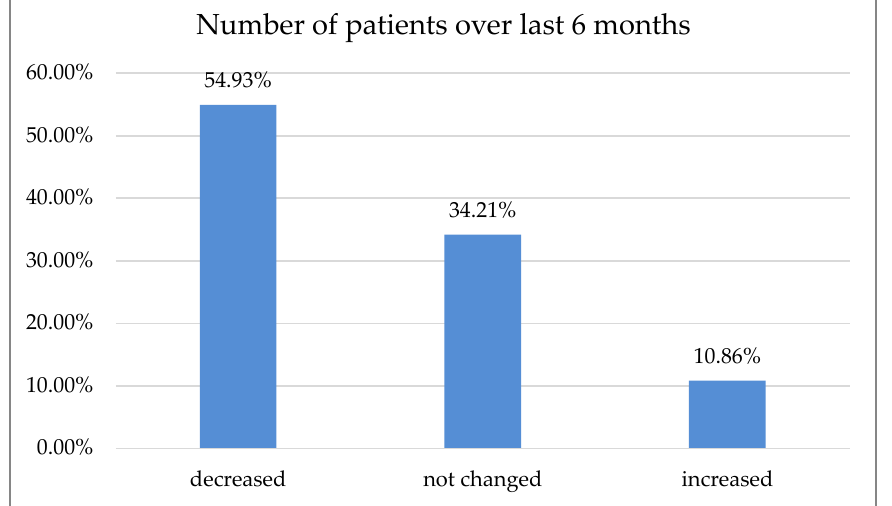
Figure 2. Changes in the number of patients during the last six months.